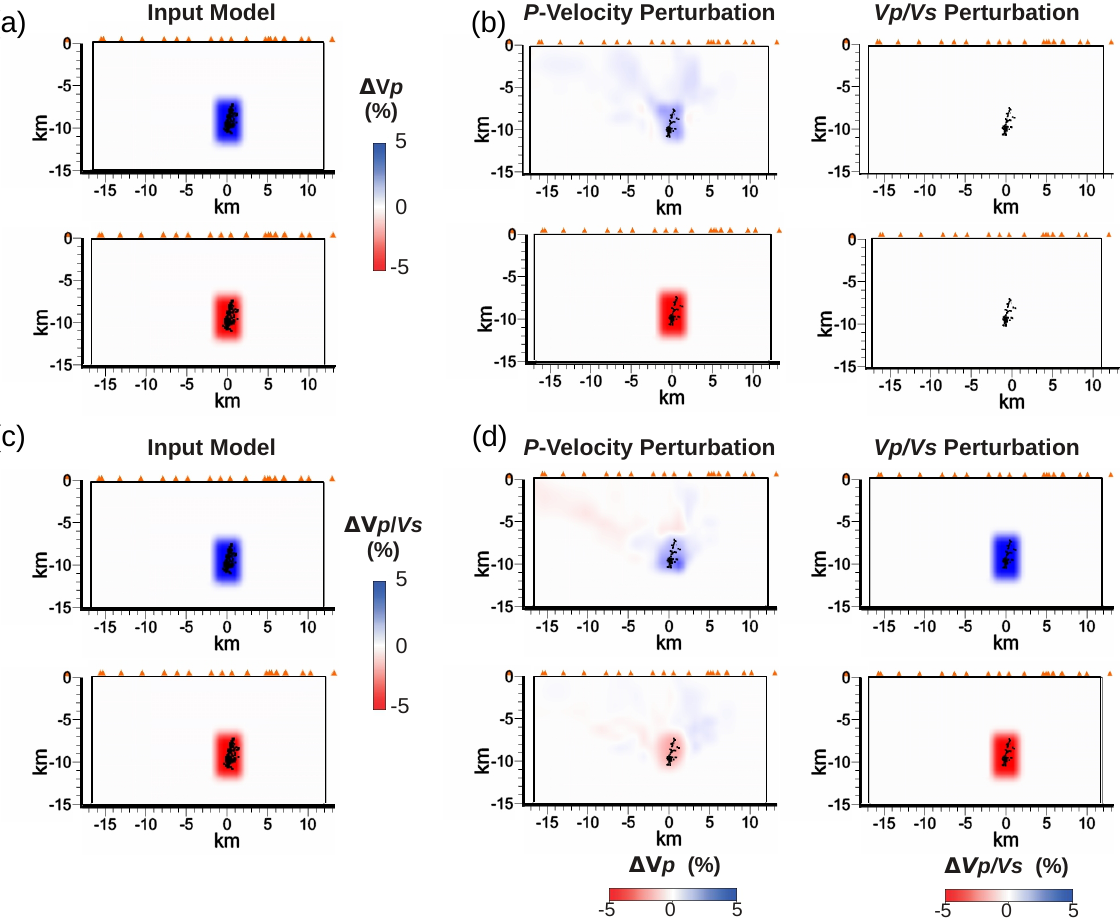
Figure 3. Anomaly restoration synthetic test. A block 3km wide in the x direction, 6km wide in the y direction, 5km deep and enclosing all earthquakes is perturbed. Within the block, (a) P wave velocities are modified by ± 5% or (c) Vp / Vs ratio is perturbed by ± 5%. All velocities and ratios outside the block correspond to the regional model of Málek et al. (2001). The recovered models – (b) and (d) – all show that the Vp / Vs is well recovered. The recovered P -wave velocity models show some smearing and are also influenced by fluctuation in the Vp / Vs